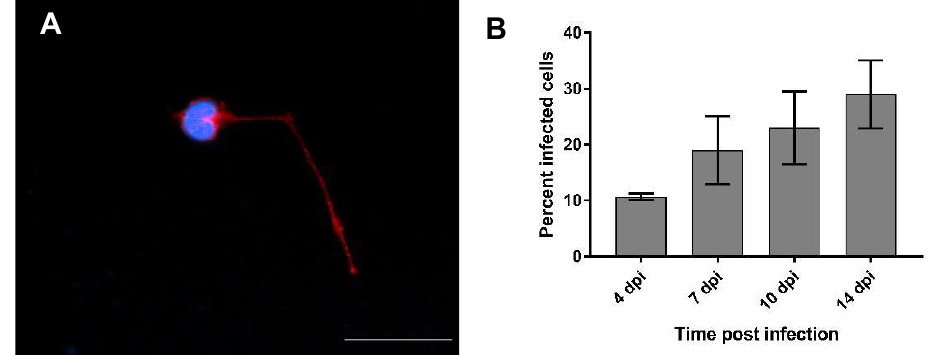
Figure 4. Immunofluorescence of the OM culture for the detection of olfactory receptor neurons (ORNs). ( A ) Olfactory neuron after two days in culture (ic). β III-Tubulin—Cy2; nuclear staining: 4’,6-diamidino-2-phenylindole (DAPI); ic—in culture. Scale bar: 20 µm. ( B ) Percentage of olfactory neurons in the primary culture of the OM over time. Arithmetic mean, error bars: standard deviation.